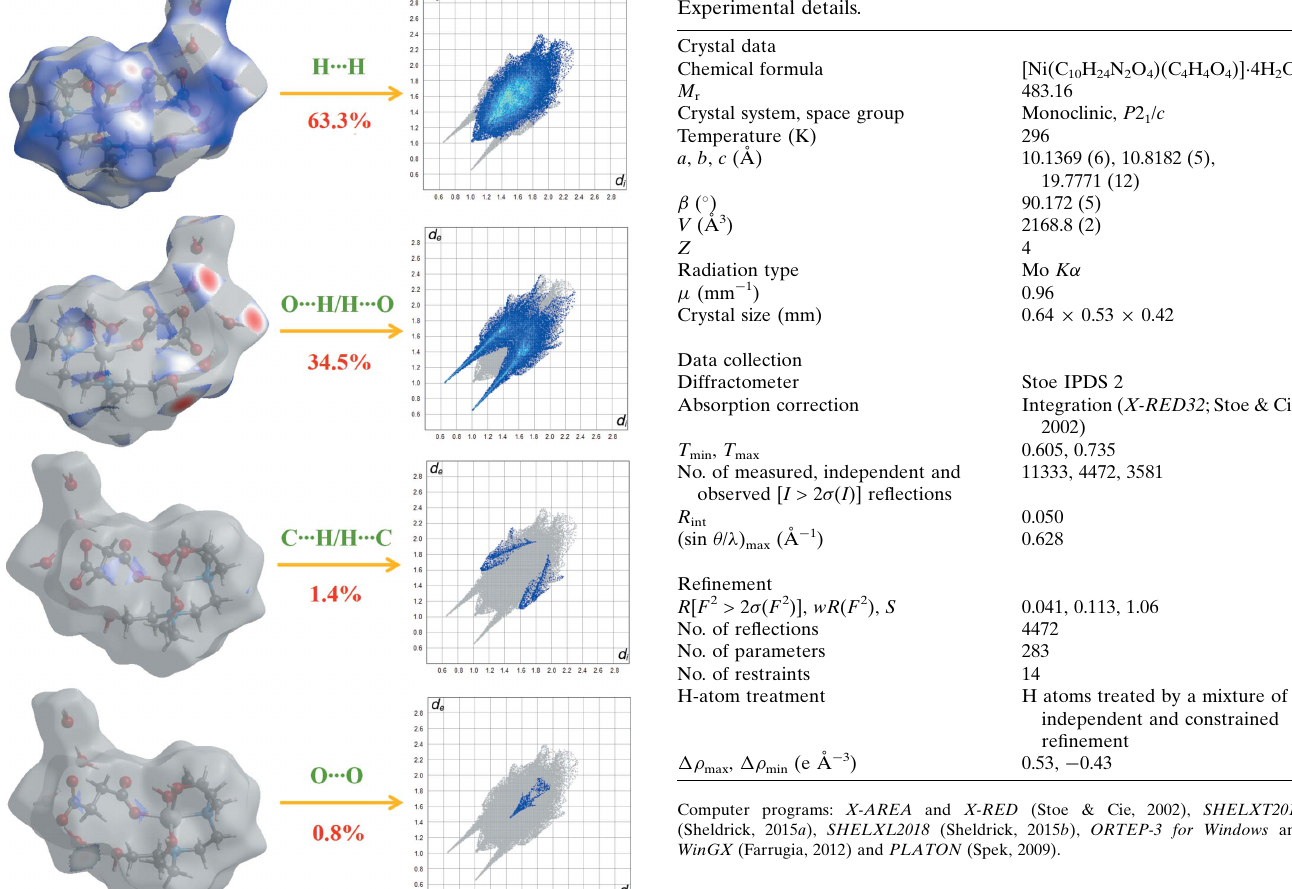
Figure 6 Two-dimensional fingerprint plots with a d norm view of the H (cid:2)(cid:2)(cid:2) H (63.3%), O (cid:2)(cid:2)(cid:2) H/H (cid:2)(cid:2)(cid:2) O (34.5%), C (cid:2)(cid:2)(cid:2) H/H (cid:2)(cid:2)(cid:2) C (1.4%) and O (cid:2)(cid:2)(cid:2) O (0.8%) contacts in the title compound.